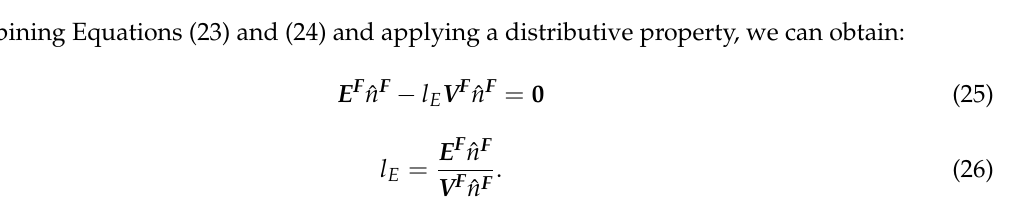
Figure 6. Equilibrium of forces in point